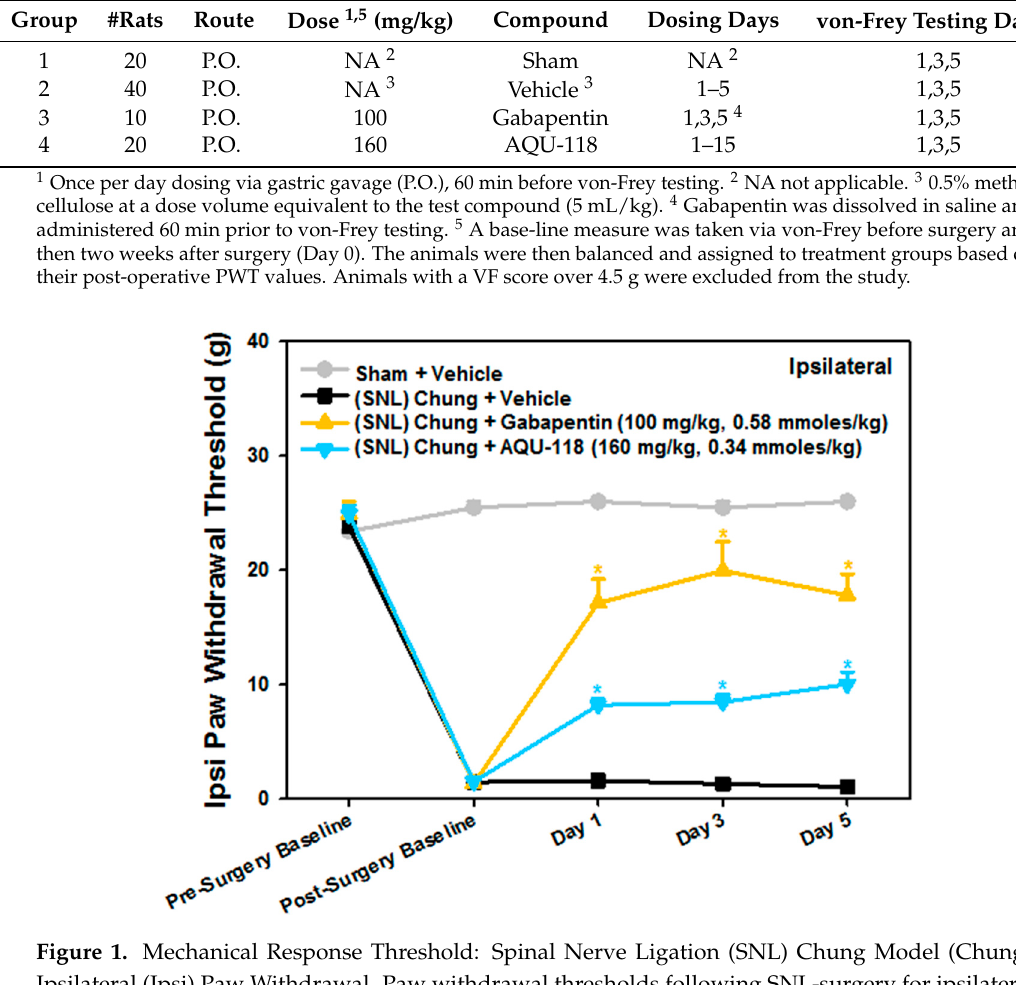
Figure 2. Mechanical Response Threshold: Spinal Nerve Ligation (SNL) Chung Model (Chung), Contralateral (Contra) Paw Withdrawal. Contralateral paw withdrawal thresholds following surgery and administration of AQU-118. Data are presented as mean ± SEM.